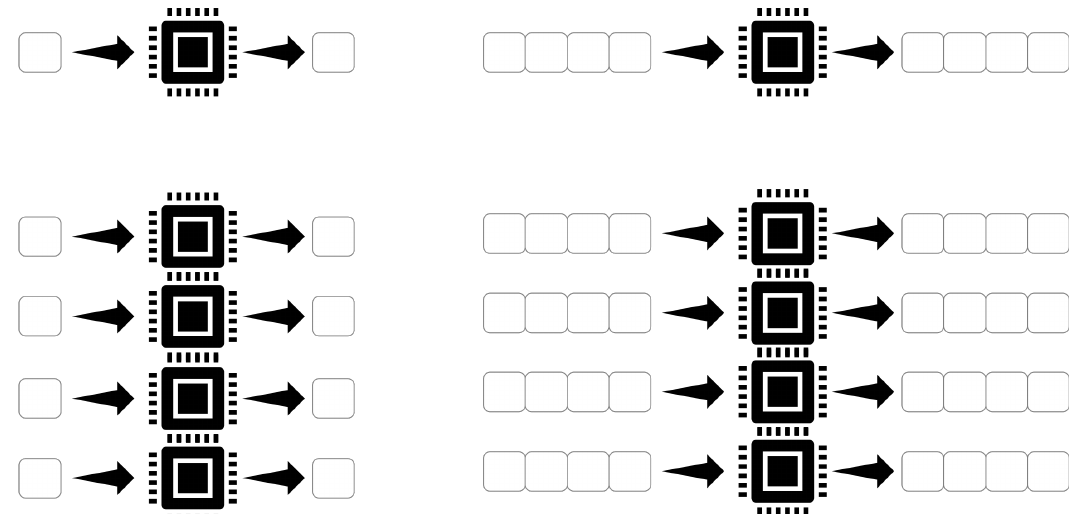
Figure 5. Parallel computing paradigms exploitable in multi-core CPUs such as the one inside the SoC of the Raspberry PI 3B. ( Top-Left ) No optimization, ( Top-Right ) single instruction multiple data (SIMD), ( Bottom-Left ) Multi-threading, ( Bottom-Right ) SIMD and